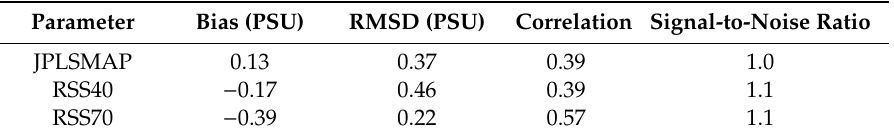
Table 2. Bias, RMSD, correlation, and signal-to-noise ratio for JPLSMAP, RSS40, RSS70, with respect to the Saildrone-derived